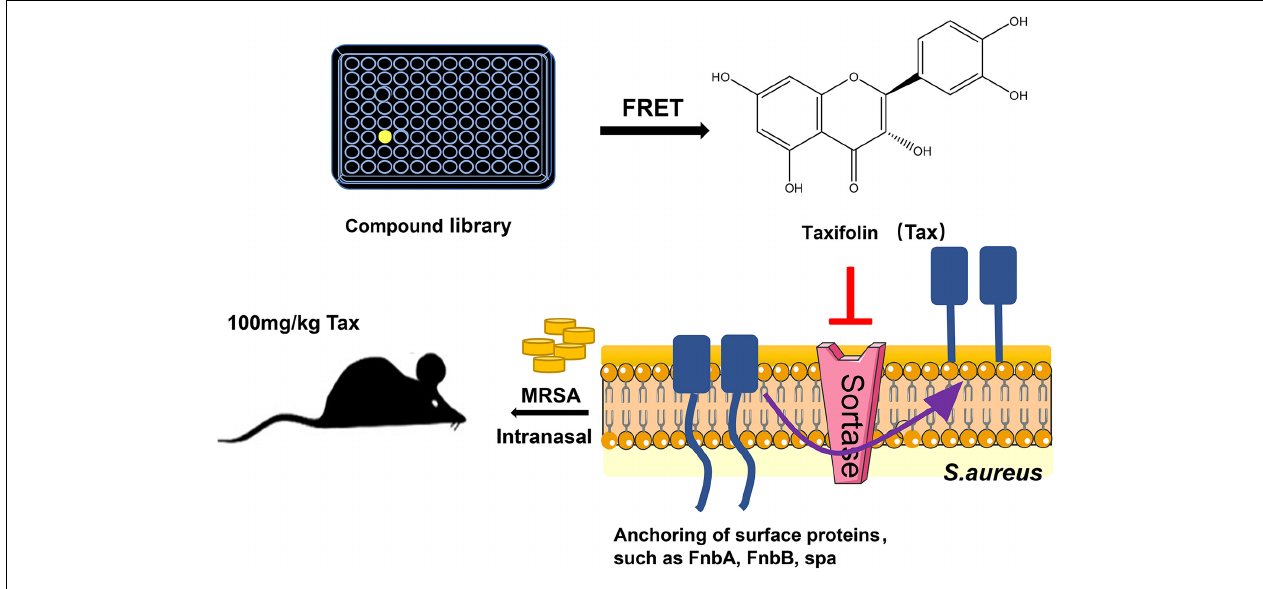
FIGURE 7 | Experimental flow